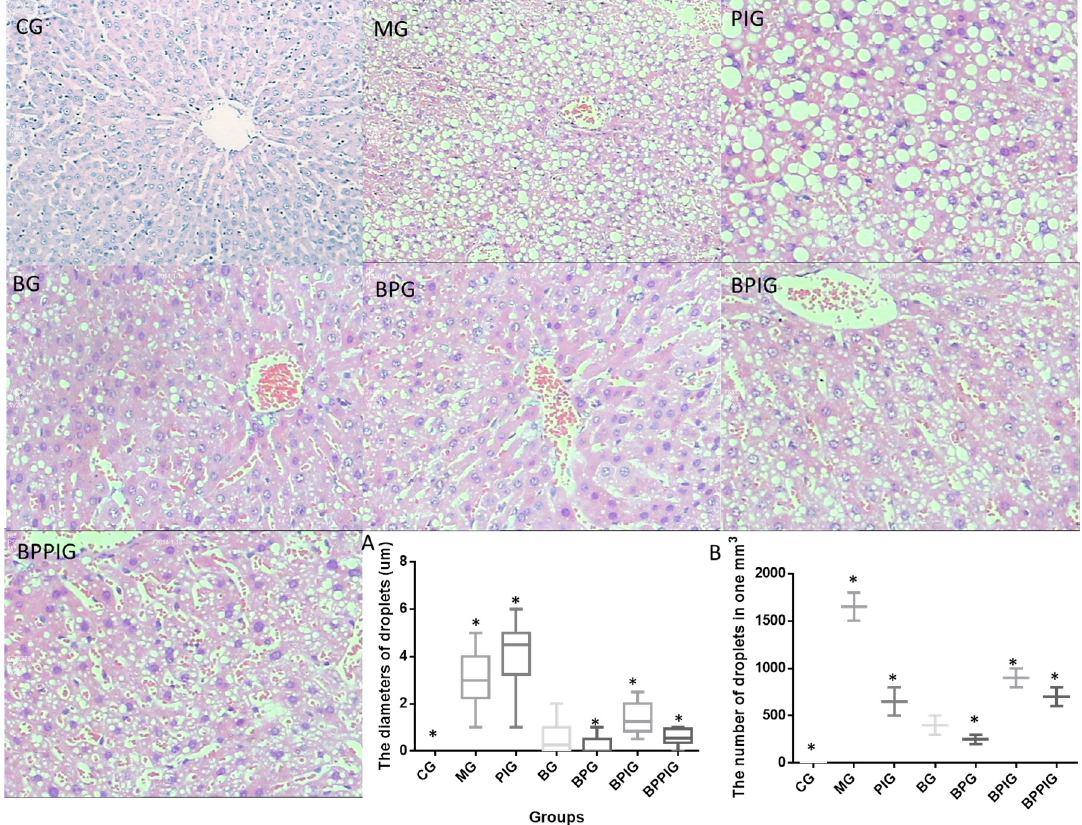
Figure 5. HE analysis for the effects of BP on NASH and liver damage: ( A ) the diameters of lipid droplets in different groups; and ( B ) the concentration of lipid droplets in different groups. Eight liver samples were analyzed in each group. All data are presented as mean value ± S.D. * p < 0.05 via a blueberry juice group BG.